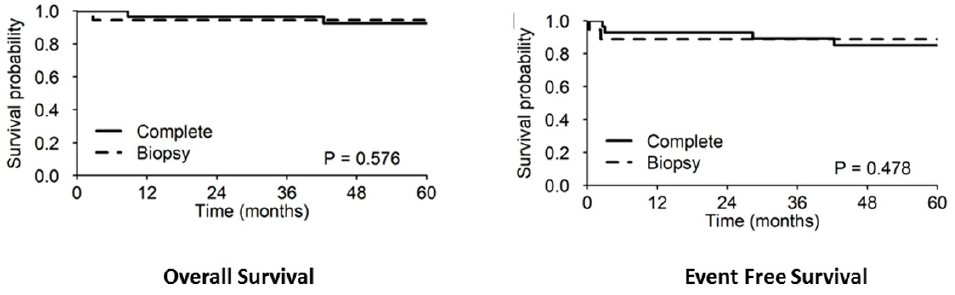
Figure 4. The 5-year OS/EFS rates in females vs. males.